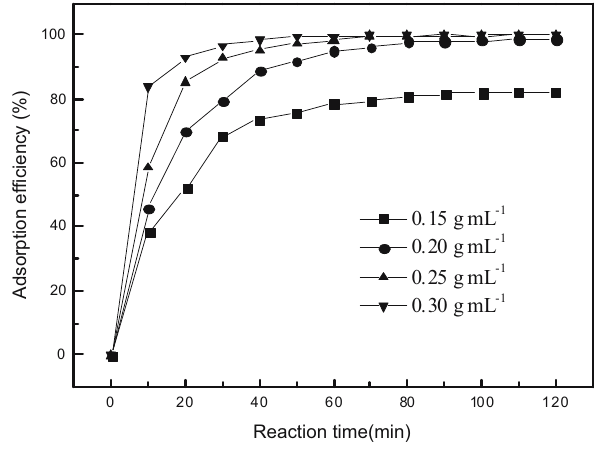
Figure 1: E ff ect of resin dosage on the adsorption e ffi ciency for GPC by resin 001 × 7.